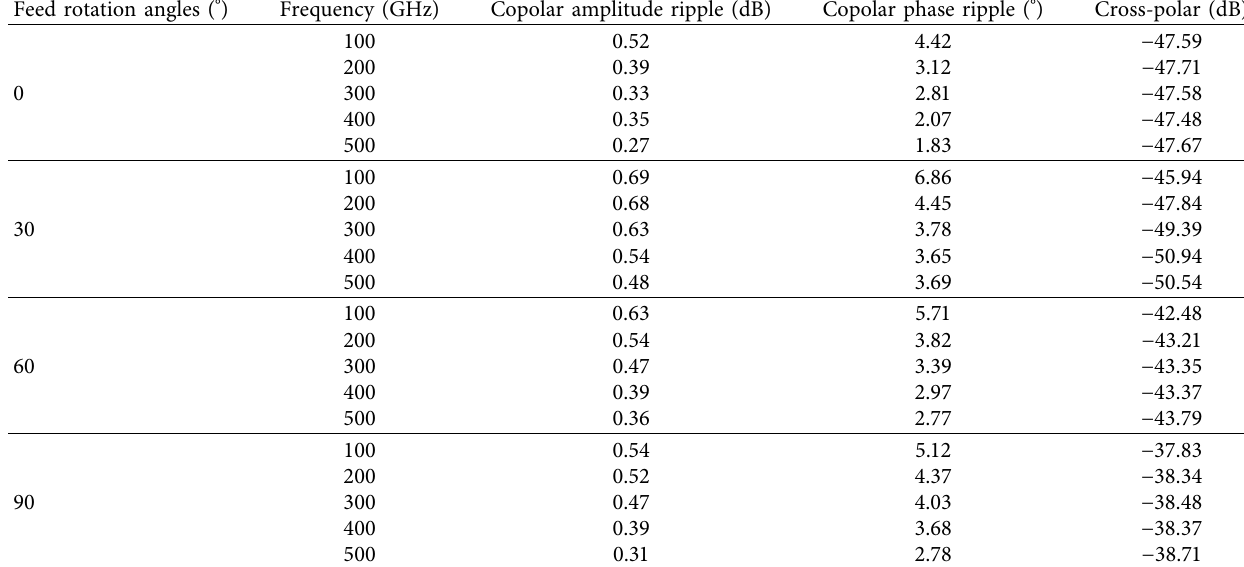
Figure 8: PO +PTD one-dimensional normalized simulation results of the designed tri-refector CATRs with diferent feed rotation angles at 500GHz. (a) Cross-polar isolation, (b) copolar amplitude, and (c) copolar phase. Table 3: Quiet zone performance of the four designed tri-refector CATRs corresponding to four diferent feed rotation angles (the QZ usage is